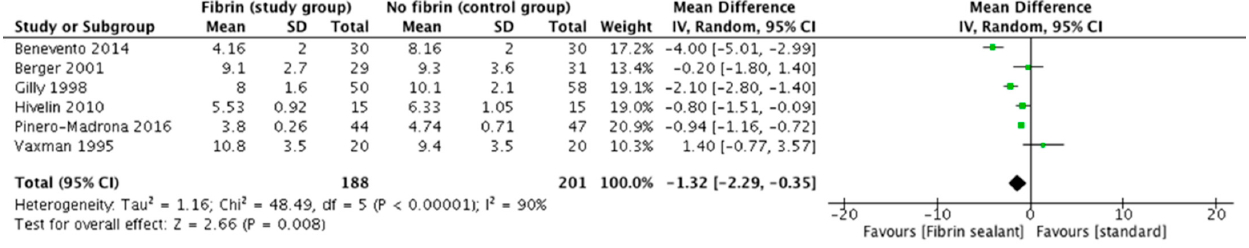
Figure 4 . Days of hospital stay. Figure 4. Days of hospital